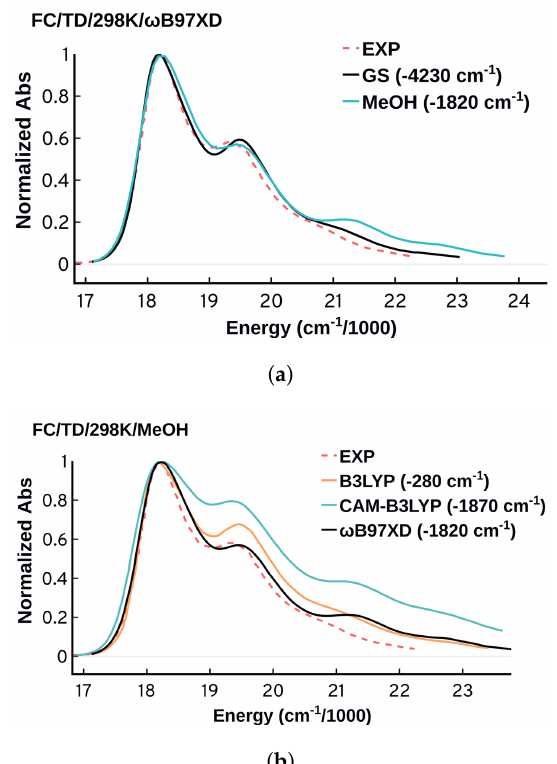
Figure 10. ( a ) FC spectra obtained from ω B97XD in gas-phase (ground and excited state optimized in the gas-phase) and methanol/MeOH (ground and excited state optimized in implicit solvent methanol via PCM) ( b ) Comparing the performance of B3LYP, CAM-B3LYP, and ω B97XD using methanol as an implicit solvent. All the spectra were obtained at 298 K using TD and were plotted using standard deviation of 150 cm − 1